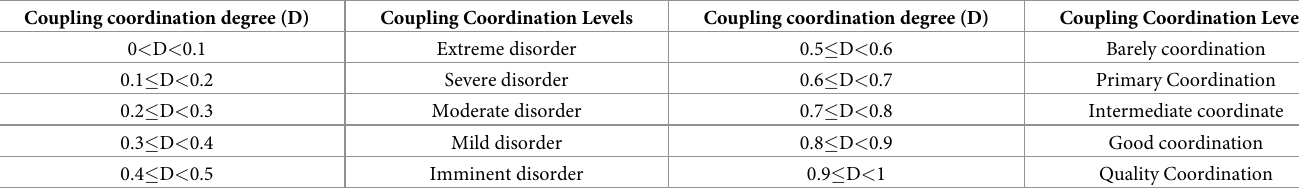
Table 2. Classification of coupling coordination levels.